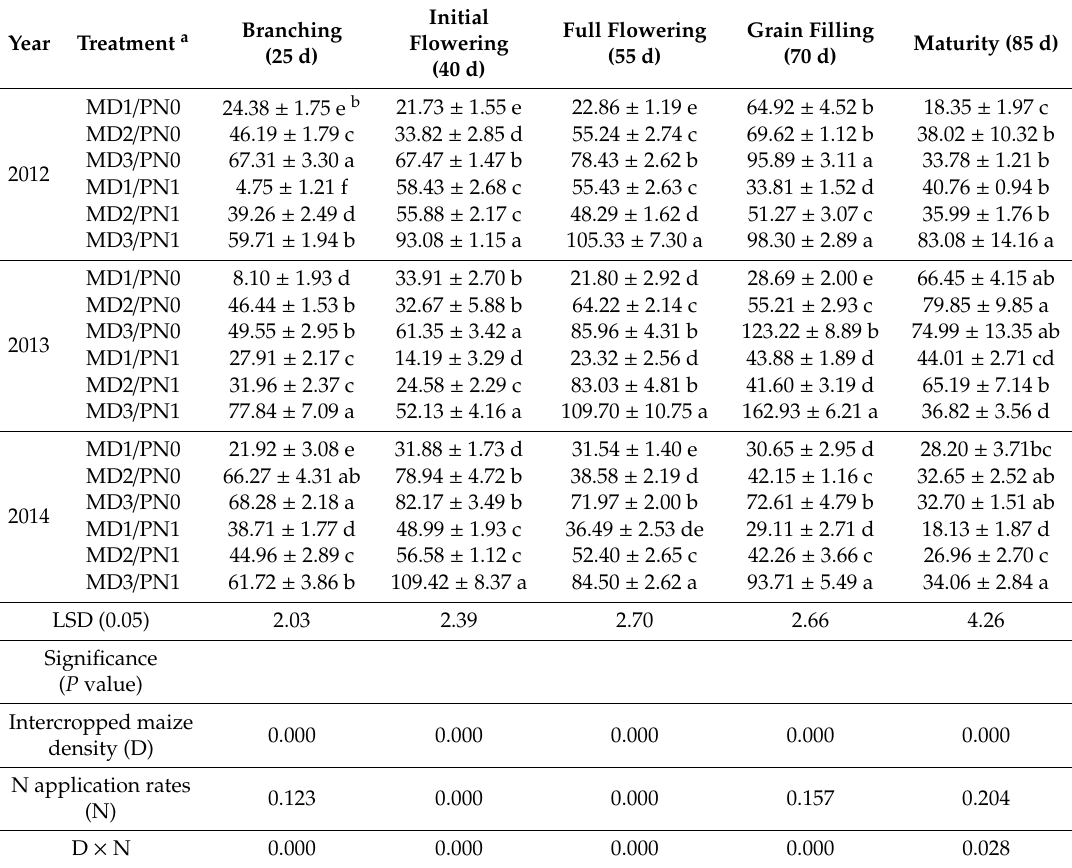
Table 2. Alleviation of the inhibitory e ff ect of soil mineral N on nodulation of intercropped pea as a ff ected by treatment, stage of pea phenological development, and